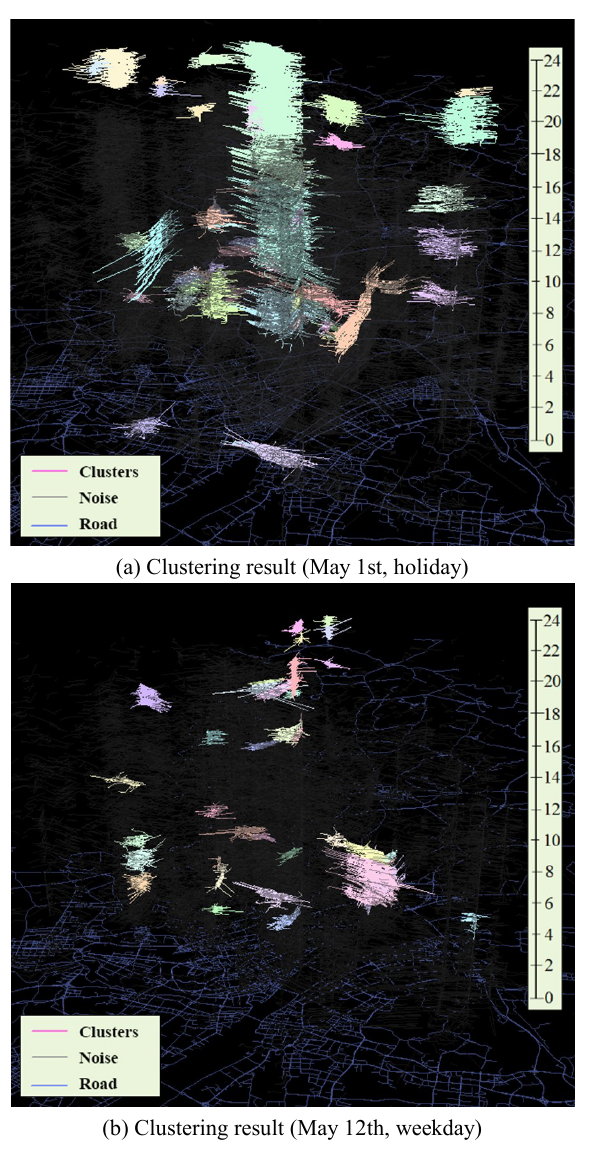
Figure 6 Trajectory clustering results in 3D